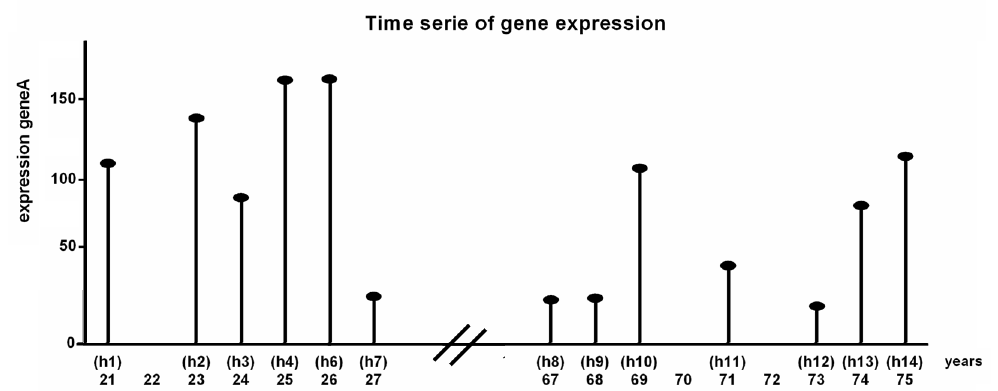
Figure 4. Schematic representation of one gene in the gene expression data (NCBI GEO ID GSE362). In the experiments muscle samples from 15 healthy humans of different age (21–75) were taken. The samples were arranged in ascending order by age to form a time-series. Samples of all humans between 21–27 years represent the young phenotype. The samples of all humans between 67–75 years represent the aged